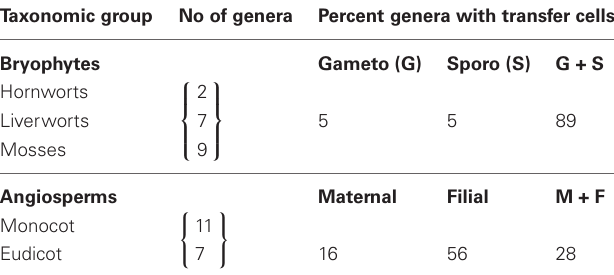
Table 3 | Location of transfer cells at the interface between generations in Bryophytes and developing seeds of Angiosperms during their storage phase of